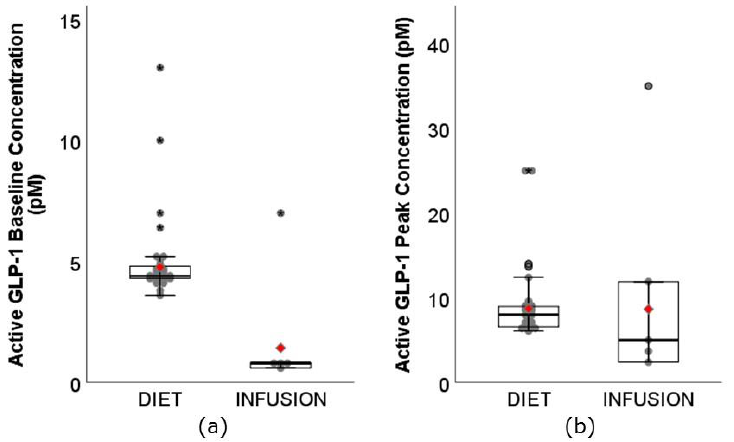
Figure 5. Boxplots showing the ( a ) baseline concentration, and ( b ) C max, peak concentration of active GLP-1 between DIET (N = 683, K = 29) and INFUSION (N = 81, K = 5). The weighted means were significantly di ff erent between DIET and INFUSION for ( a ) baseline concentration ( p < 0.01), but not ( b ) C max, peak concentration ( p =